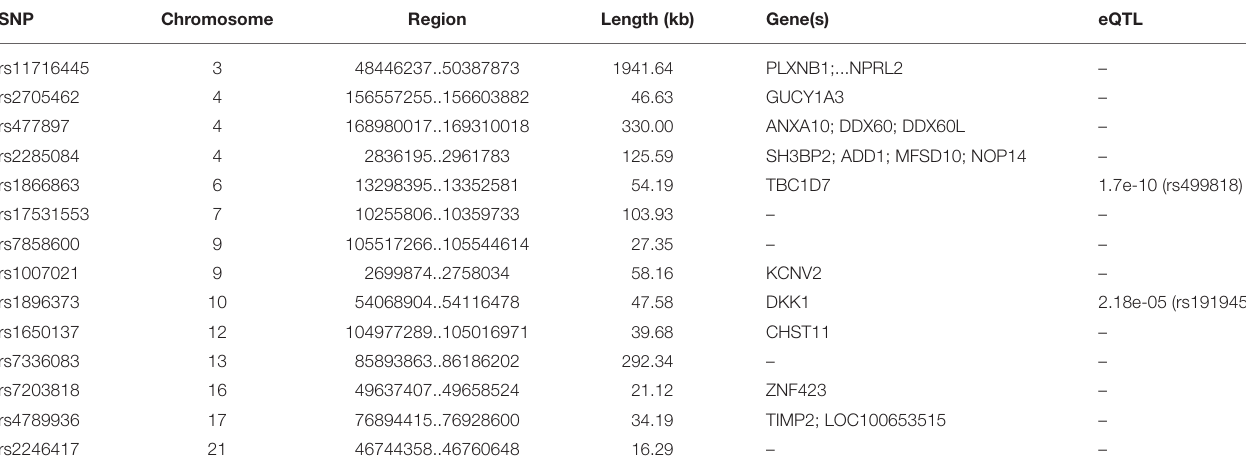
TABLE 3 | LD-regions that are captured by the top SNPs in our study. SNP Chromosome Region Length